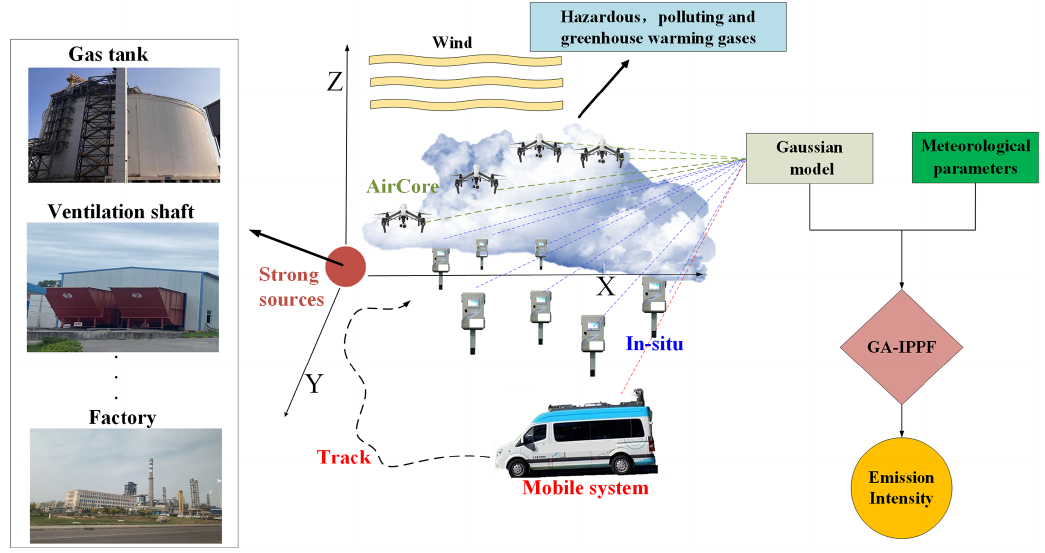
Figure 9. Application of GA-IPPF in quantifying emission sources of gases through different sample systems, including the UAV-based AirCore system, ground-based in situ network, and mobile collection